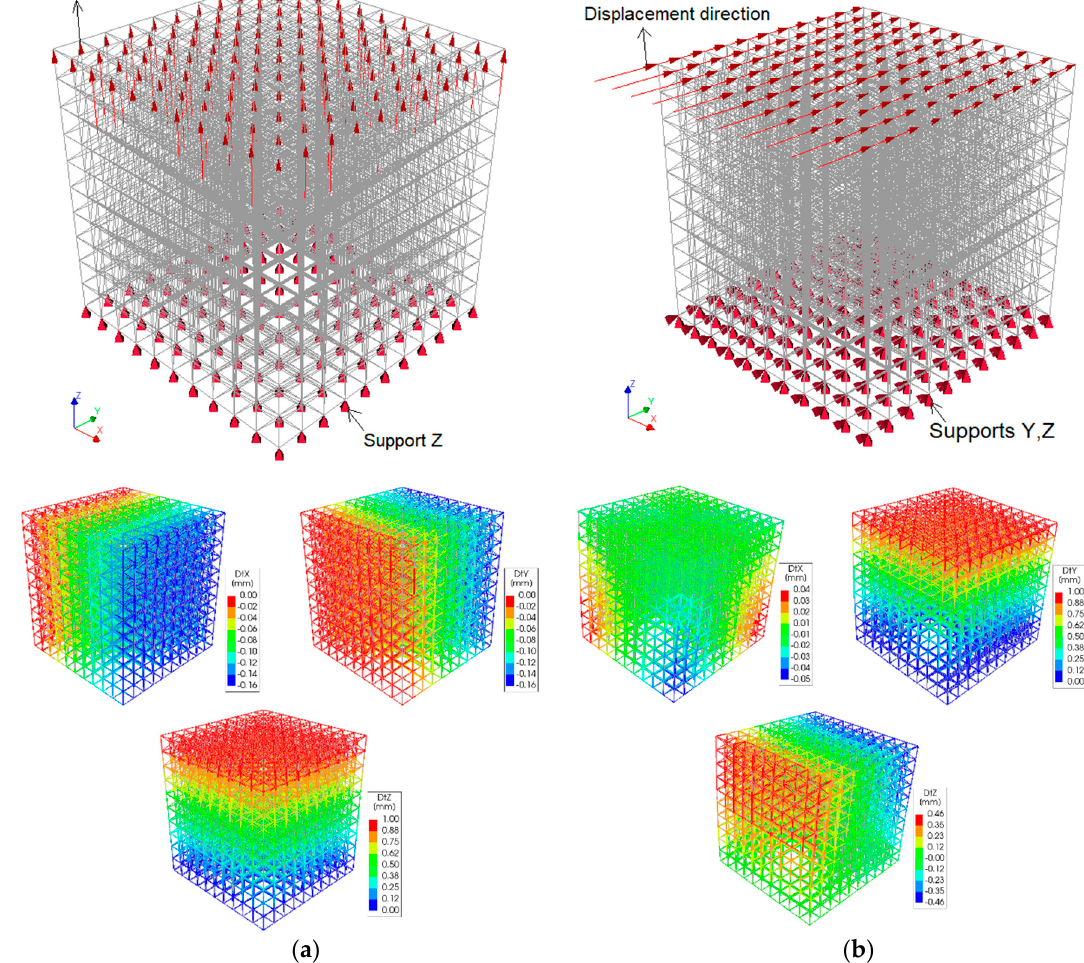
Figure 8. The configuration of a homogeneous lattice model of a 20 × 20 × 20 μ m 3 REV and deformation fields: ( a ) direct tensile model; ( b ) direct shear model (DtX, DtY, and DtZ are, respectively, deformation in X , Y and Z directions).